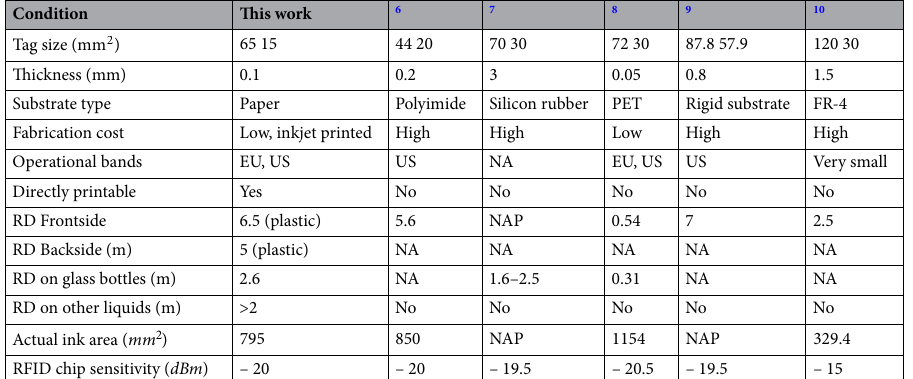
Table 2. Comparison of proposed tag antenna with state of the art. c Available, NAP stands for Not